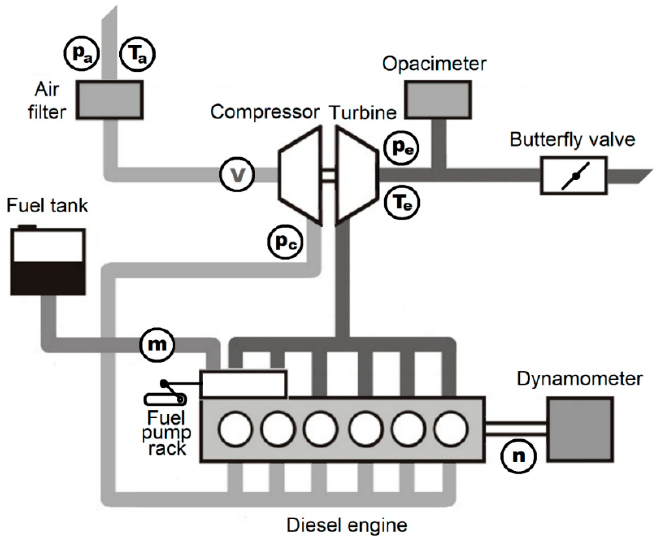
Figure 1. The diesel engine test configuration. Sensors: m—mass flowmeter; n—tachometer; p—manometer; T—thermometer; and V—volumetric flowmeter.